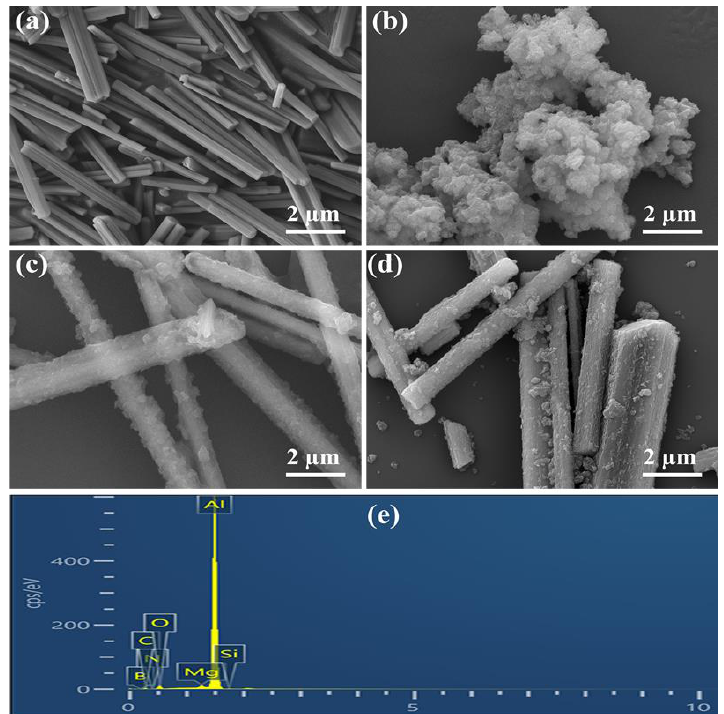
Figure 3. MBR images from SEM ( a ), LDHP ( b ), MBR@LDHP ( c ), and MBR@LDHP-APES ( d ); EDS spectrum of MBR@LDHP-APES ( e ).